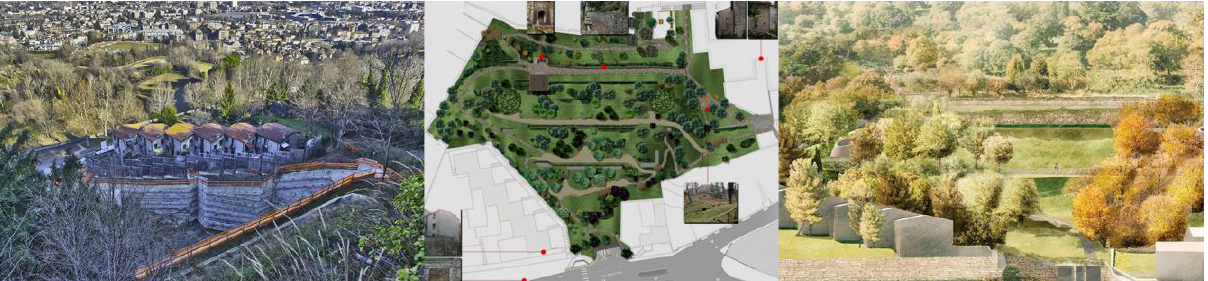
Figure 10. The construction site of the new parking in via